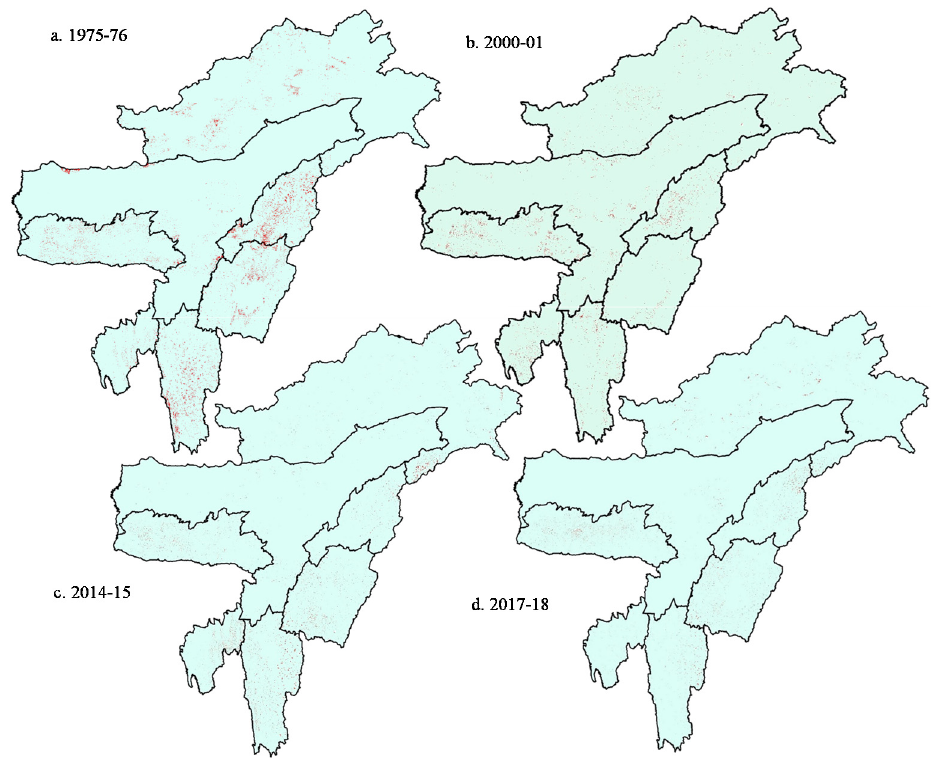
Figure 6. The shifting cultivation maps were generated for seven states of NE India for four time periods ( a ) 1975–1976, ( b ) 2000–2001, ( c ) 2014–2015, and ( d ) 2017–2018 with over 85% of classification accuracy. Table 1. Classification accuracy assessment of shifting cultivation mapping in NE